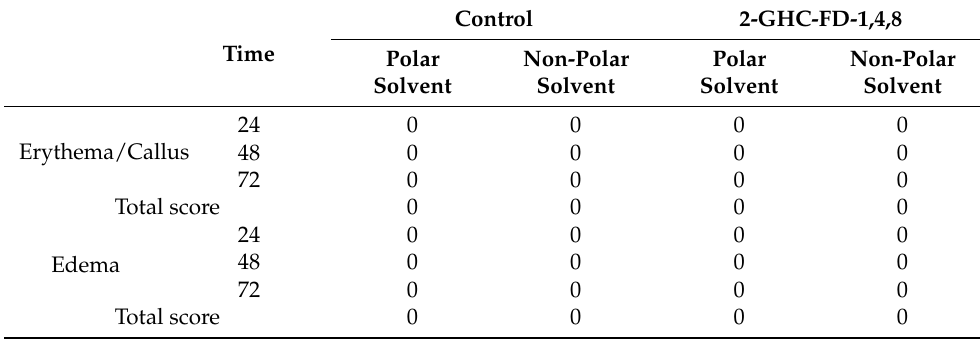
Table 4. Score of animal intradermal reactivity of 2-GHC-FD-1, 2-GHC-FD-4, and 2-GHC-FD-8 observed at 24, 48, and 72 h after injection using polar and non-polar solvents. The reactivity was confirmed by erythema, callus, and